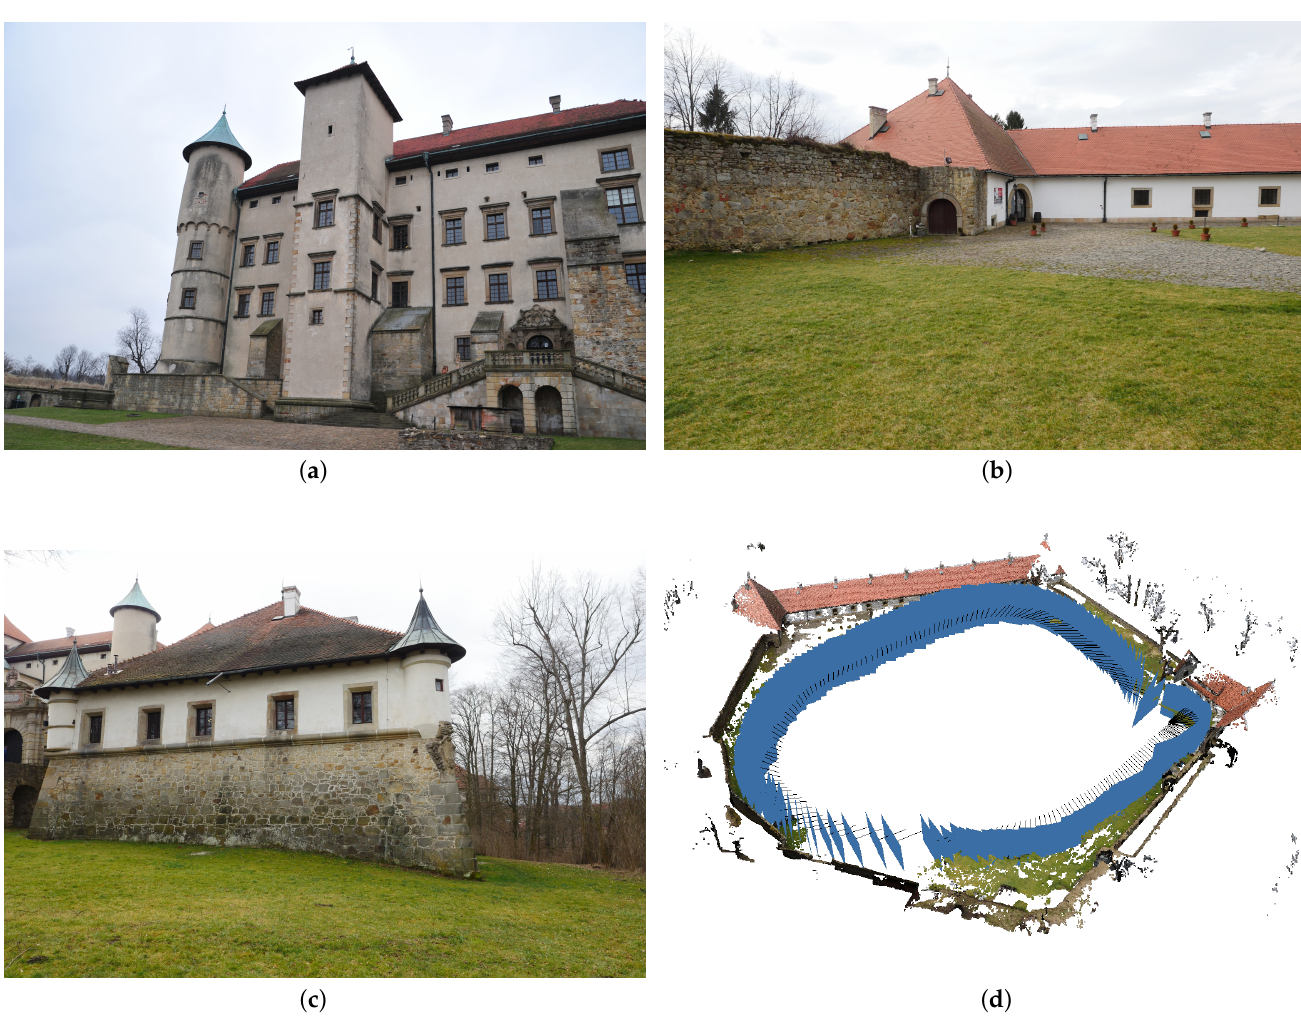
Figure 3. Examples of photographs for individual sets of terrestrial photography ( a – c ); estimation of photo locations for a sample set of terrestrial photography ( d ).